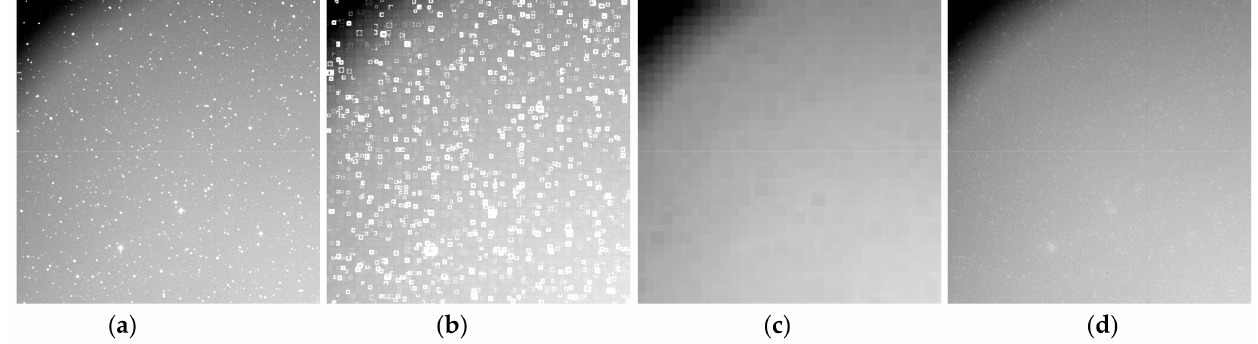
Figure 6. Morphological operation results. ( a ) Original real surveillance image; ( b ) dilation operation result after Equation (11); ( c ) erosion operation result after Equation (12); and ( d ) minimum value result after Equation